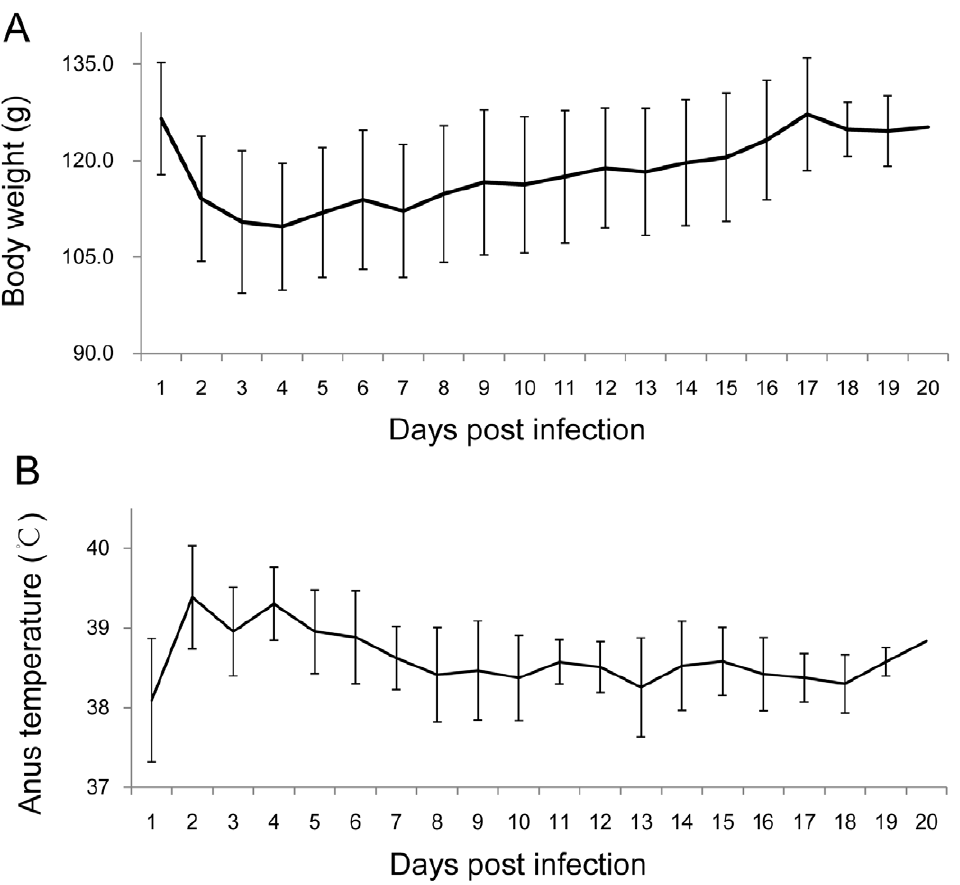
Figure 1. Post infection changes in the average body weight (A) and average anal temperature (B). Approximately 2.0 6 10 9 CFU of Y. pestis strain 2505 was injected subcutaneously into the groin of 18 great gerbils on day 0, and then observed for changes in body weight and anal temperature. The average body weight and anal temperature of the 18 animals were employed to represent the changing trends at different time points (days) post